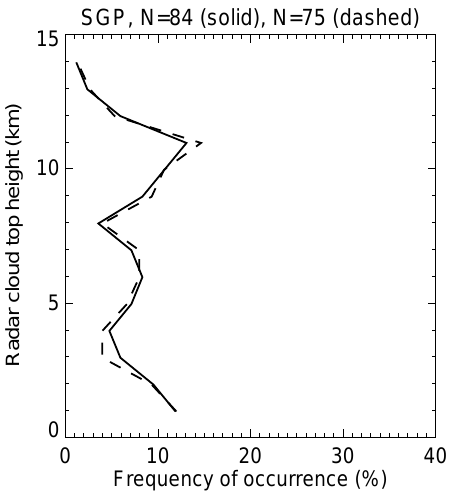
Fig. 1. Cloud-top height frequency of occurrence for all dates with radar data at SGP (solid line) and for cases that obeyed the three thresholds imposed for removing broken cloud cases (dashed line). The cloud-top heights correspond to the median calculated over the 600s time period.